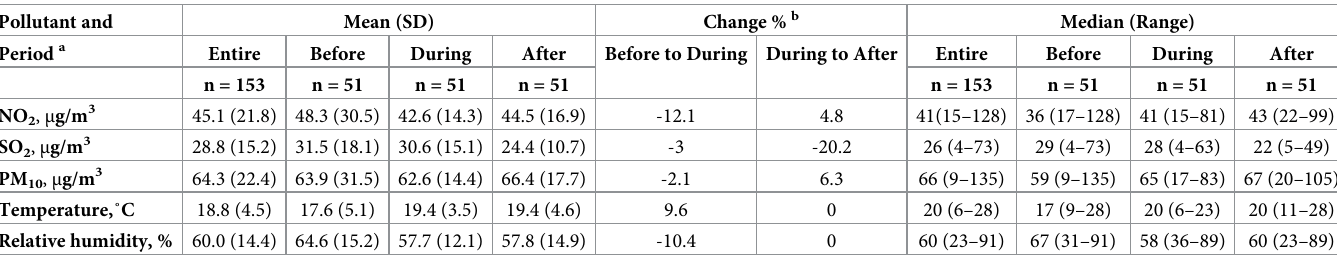
Table 3. Distributions of 24-hour mean concentrations of pollutants, temperature, and relative humidity by period. Pollutant and Mean (SD) Change % b Median (Range) Period a Before